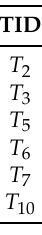
Table 3. The projected database.